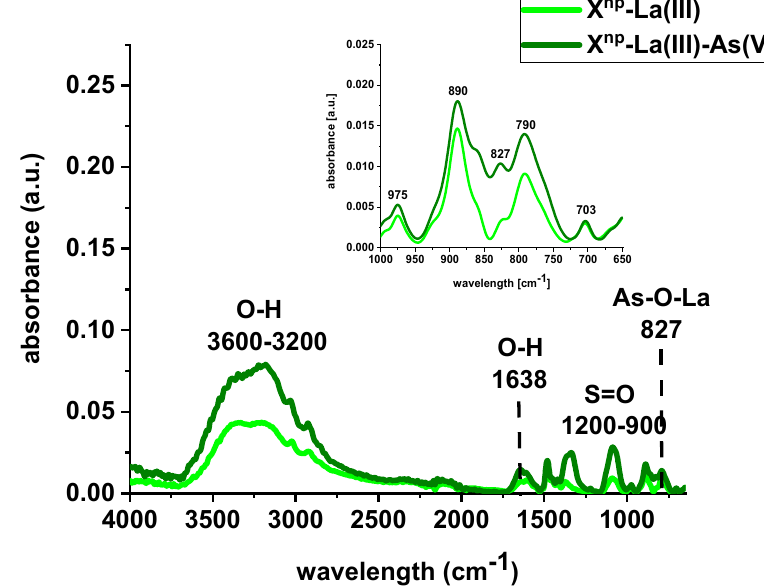
Figure 4. FTIR spectra of X np before and after sorption of As(V) ions.